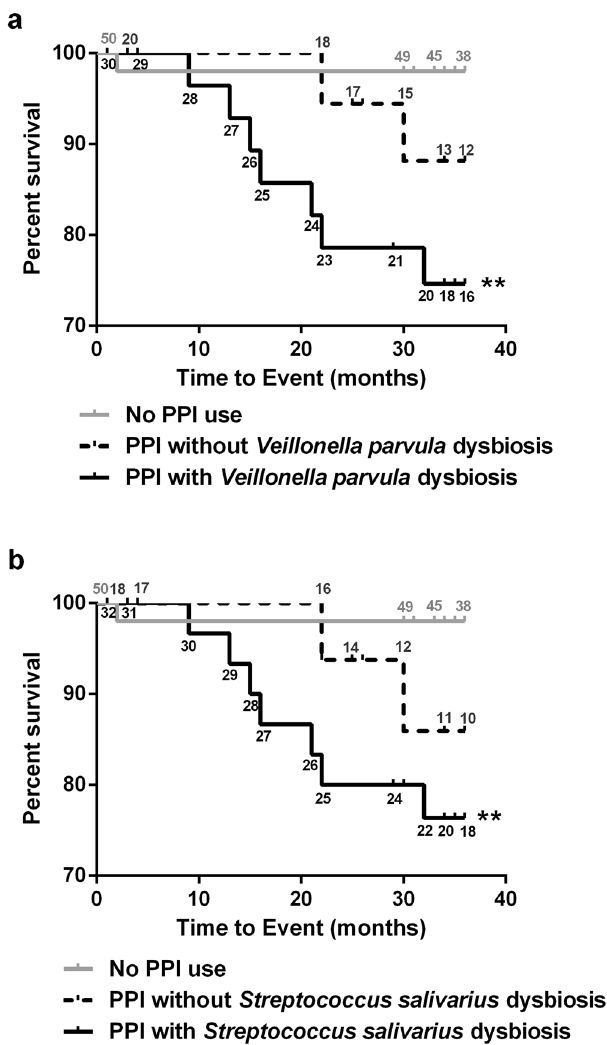
Figure 3. Biomarkers for PPI-associated dysbiosis predict liver-related three-year mortality. Kaplan-Meier curves for three-year survival according to PPI use and dysbiosis defined by ( a ) Veillonella parvula abundance and ( b ) Streptococcus salivarius . Patients at risk are given along the curves; patients at risk without PPI use are given in grey numbers; patients at risk with PPI without dysbiosis are given in black above the curve; patients at risk with PPI and dysbiosis are given in black below the curve; ** p < 0.01 compared to patients without